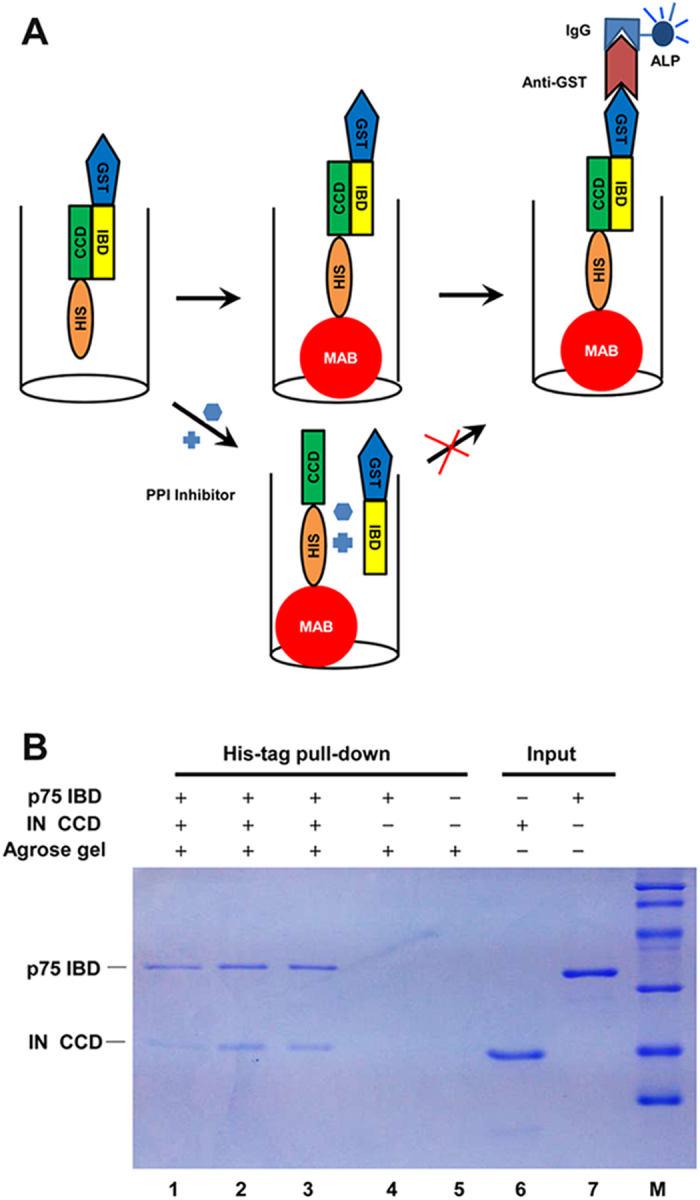
The schemes of the established assay for IN CCD-LEDGF/p75 IBD interaction and SDS-PAGE gel of His6-tag pull down assay for IN CCD-LEDGF/p75 IBD interaction.(A) GST-IBD interacts with His6-CCD in the microplate, forming the PPI complex which is captured by Ni2+-coated magnetic beads (MAB). And the amounts of PPI complex are quantified by using ALP-conjugated anti-GST antibody and ALP substrate. In the presence of the PPI inhibitors, GST-IBD cannot interact with His6-CCD, resulting in no ALP activity. (B) Recombinant LEDGF/p75 IBD was incubated with HIV-1 IN CCD containing a His6-tag at the C terminus (lane 1–3). The complexes were bound on a Ni2+ chelating resin. Lanes 6 and 7 reflect the protein input in the reactions. IN CCD was omitted in lane 4 and only agarose gel was added in lane 5. The gel was stained using Coomassie Blue R-250. The results showed that IN CCD could interact with LEDGF/p75 IBD (lane 1–3), no band was detected in controls (lane 4–5).